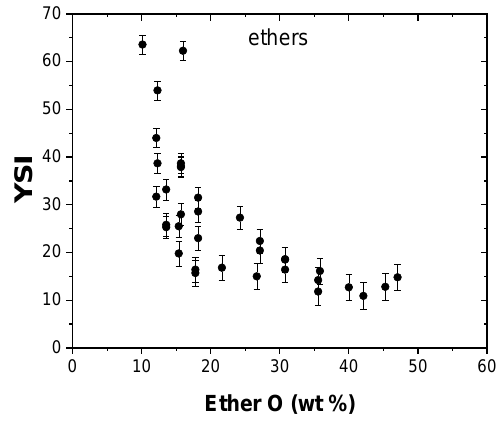
Figure 10. Effect of ether O groups on YSI .